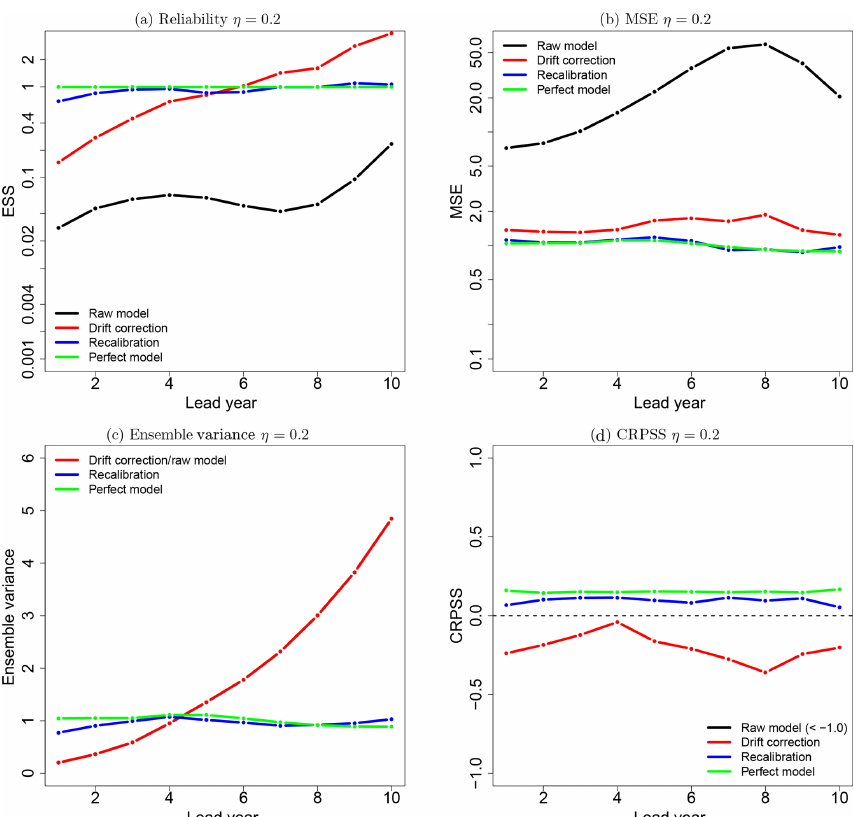
Figure 4. Reliability (a) , MSE (b) , ensemble variance (c) and CRPSS (d) of the raw toy model (black line), the drift-corrected toy model (red line), recalibrated (DeFoReSt) toy model (blue line) and the perfect toy model (green line) for η = 0 . 2. The drift correction method does not account for the ensemble spread; thus, the ensemble variance of the raw model and the drift-corrected forecast is equal. For reasons of clarity, the raw models’ CRPSS with values between − 3 and − 9 is not shown